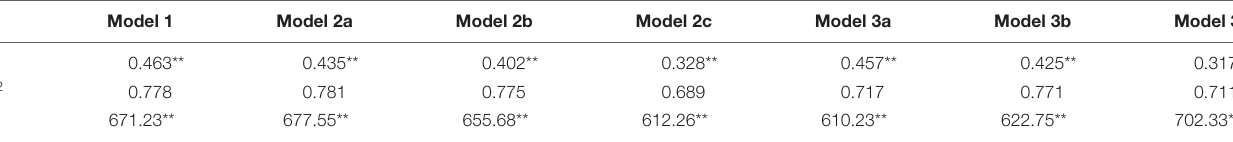
TABLE 5 | Result of simple linear